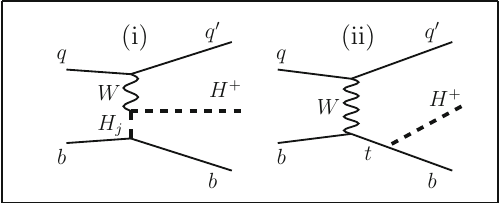
Fig. 12 Feynman diagrams for the production processes